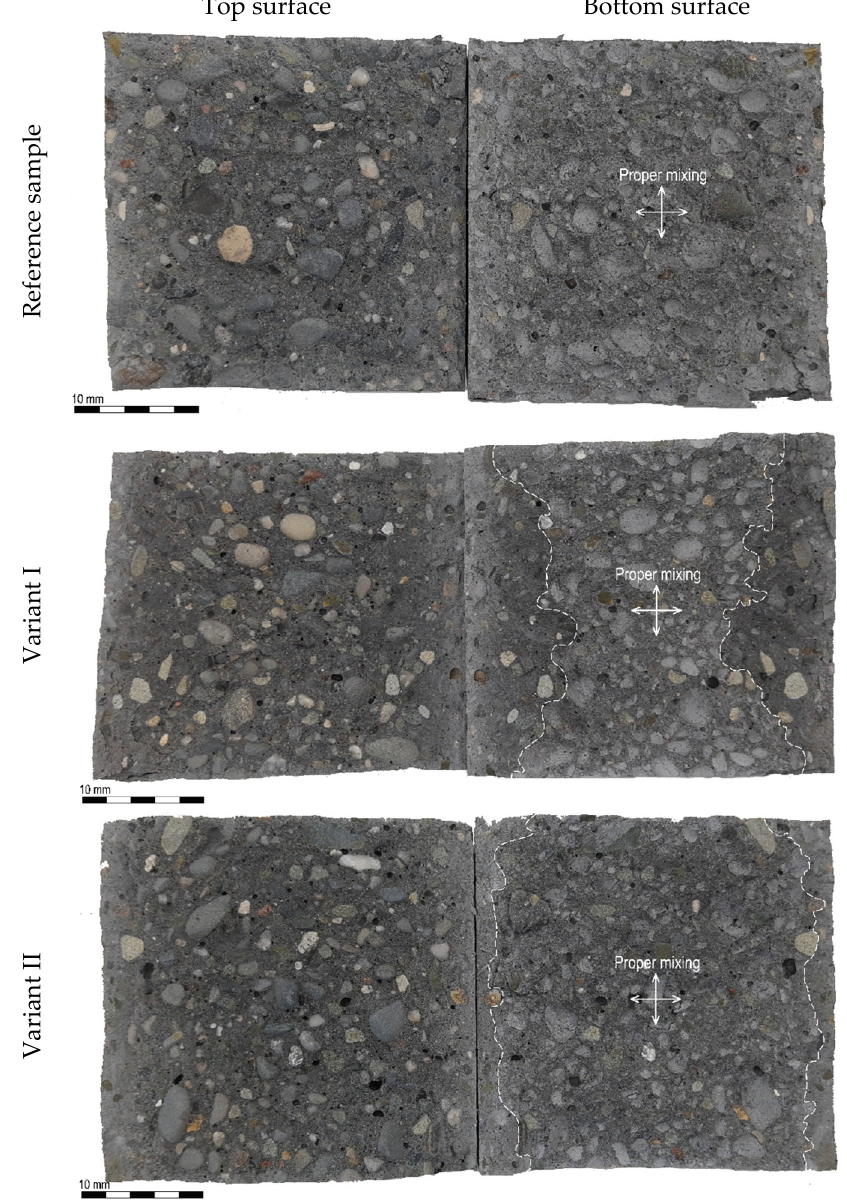
Figure 6. The examples of Eco-SCC specimen surfaces after splitting tensile strength test.